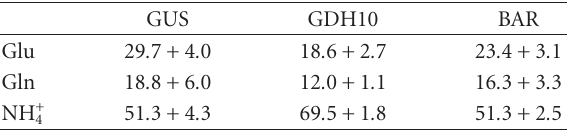
Table 3. Labeling of amino acid fractions in leaves fed 13 NH + 4 through the petiole after 15 minutes and held in nutrient solu- tion. Entire leaves were cut from 3 replicates of tobacco plants that were 6 weeks old grown in soil in a 16/8 walk in growth room at 26 ◦ C with light at about 500 microEinsteins. Incorpora- tion is expressed as a percentage of the label input plus or minus the range detected among 3 individual plant replicates and three measurement replicates.